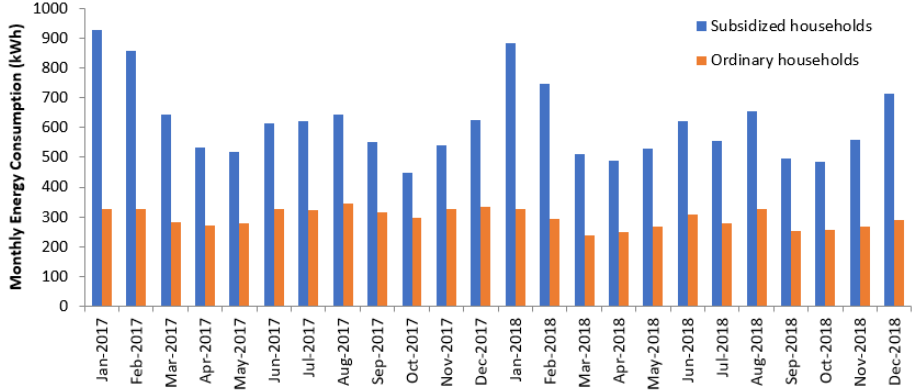
Figure 3. The average monthly electricity consumption for ordinary and subsidised households.